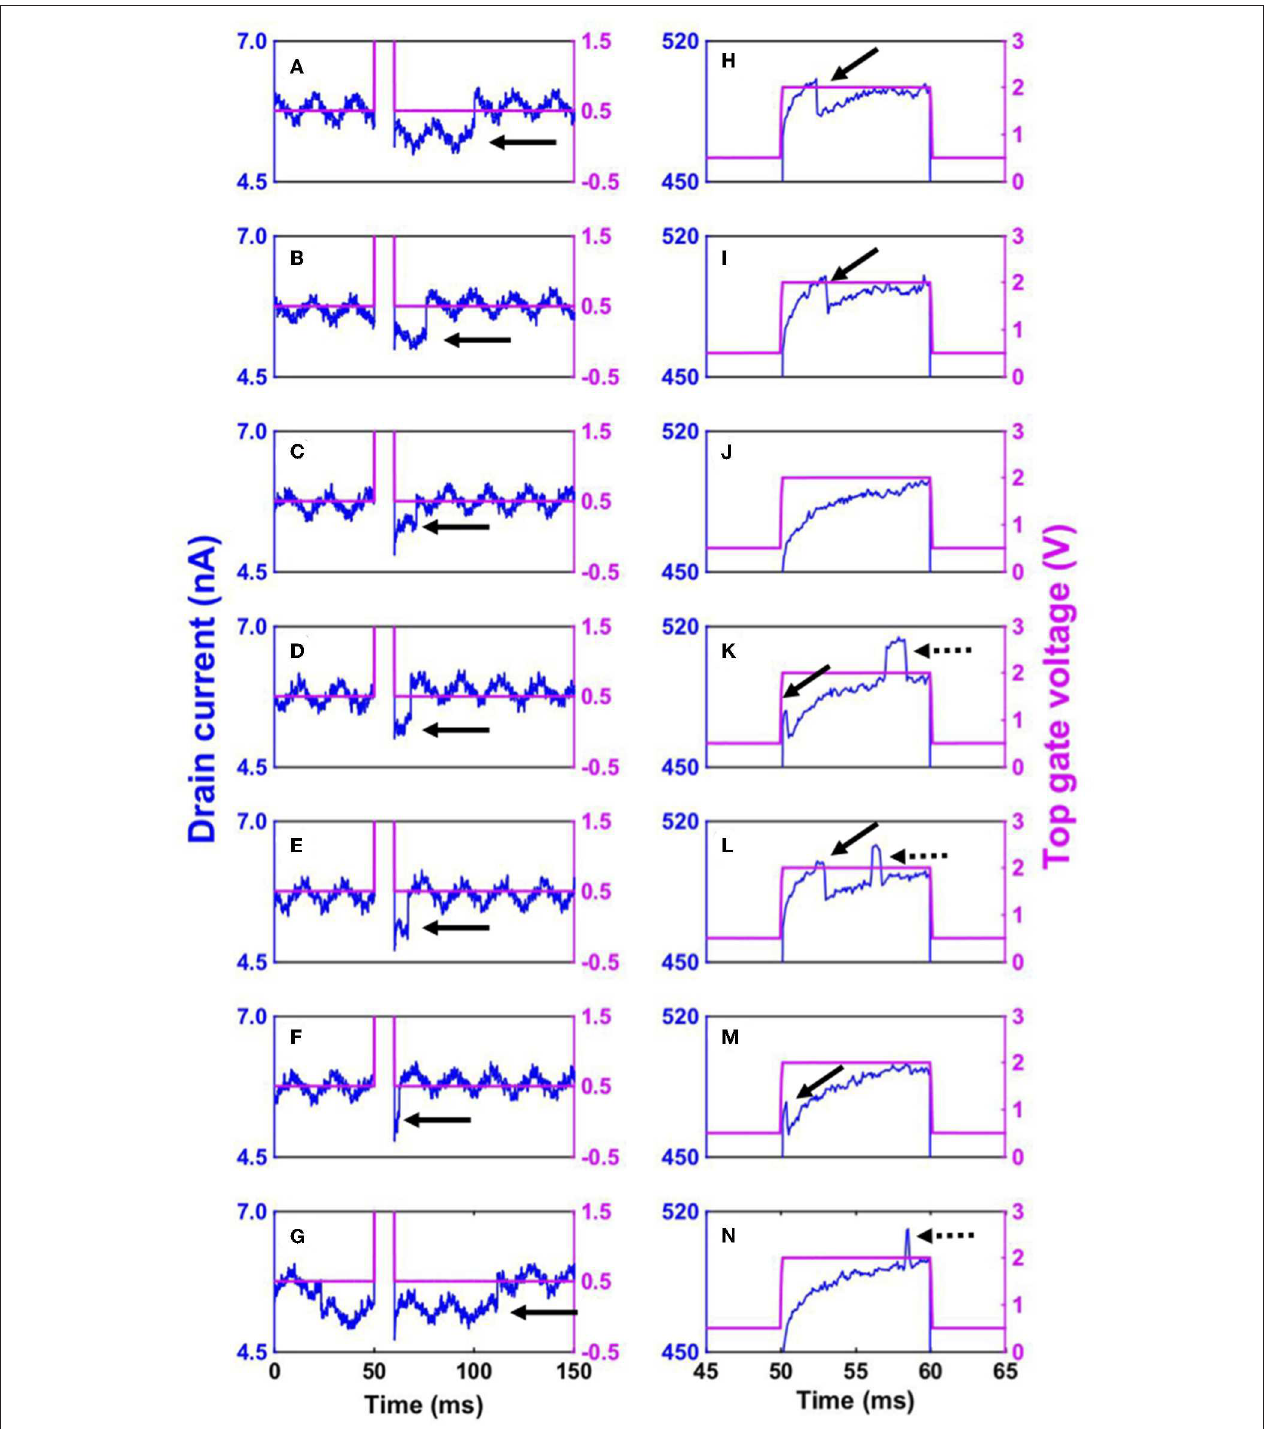
FIGURE 4 | Single electron memory effect utilizing Random Telegraph Signals. (A–G) I D monitored from 0 s to 150 ms in the range of 4.5 to 7.0 nA. (H–N) I D monitored from 45 to 65 ms in the range of 450 to 520 nA. V D was set to 0.2 V. In the first 50 ms, V TG = 0.5 V was applied to empty the QD (A–G) . After the initialization, V TG was ramped up to 2 V over 30 µ s (H–N) . Until 60 ms, V TG was kept 2 V to capture an electron in the QD (H–N) . V TG was then decreased to 0.5 V over 30 µ s, and I D was monitored for a further 90 ms (A–G)